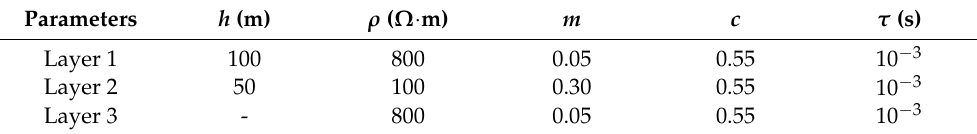
Table 4. Parameters of the three-layer model (Model 3).